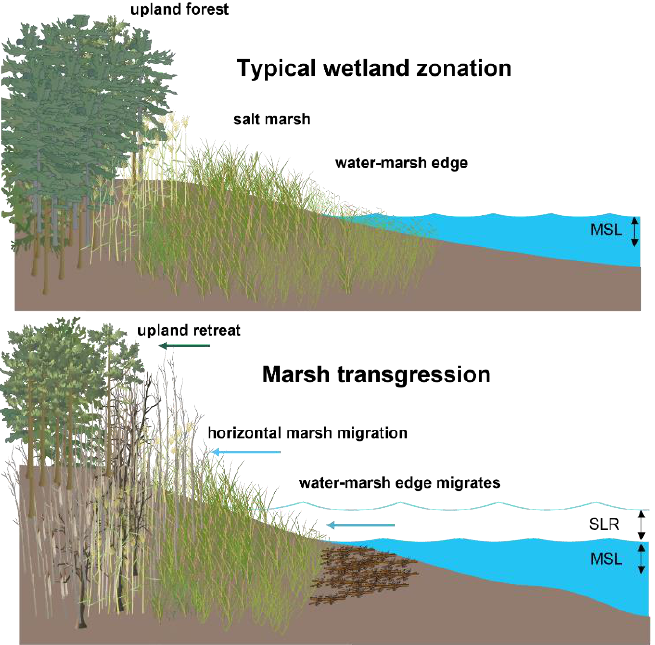
Figure 1. Conceptual diagram of the typical wetland zonation ( top panel ) and ecosystem responses to SLR ( bottom panel ). SLR causes shifts in thresholds of vegetation species, causing reconstruction of the plant zonation of the coastal landscape, leading to marsh transgression (diagram modified from ian.umces.edu/media-library).